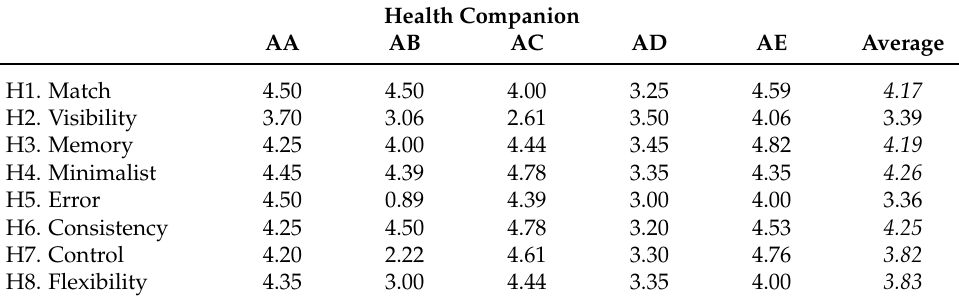
Table 9. Average usability assessments in Health